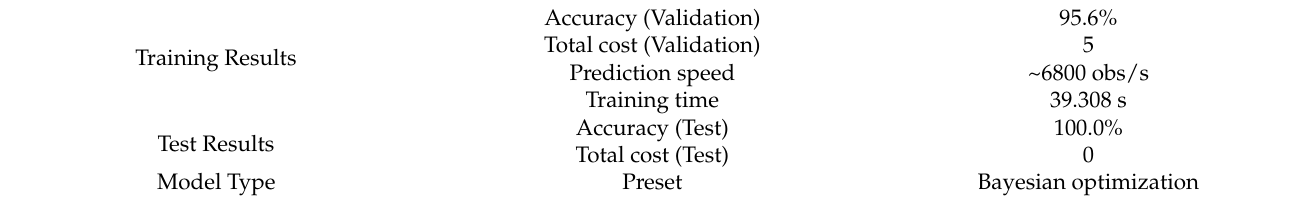
Table 7. Training results of optimized SVM model